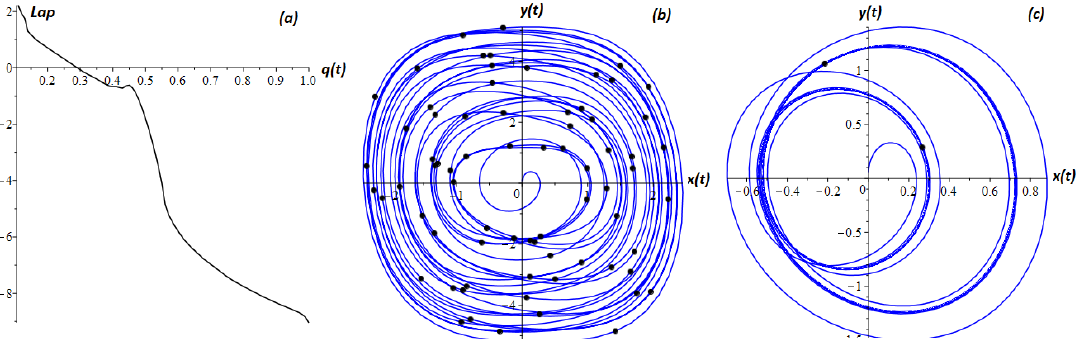
Figure 8. The spectrum of Lyapunov exponents from q ( t ) ( a ) and phase trajectories at ( b ) q ( t ) = 0.15cos 2 ( 0.2 t ) , ( c ) q ( t ) = 0.8cos 2 ( 0.5 t ) . The dots represent the Poincaré